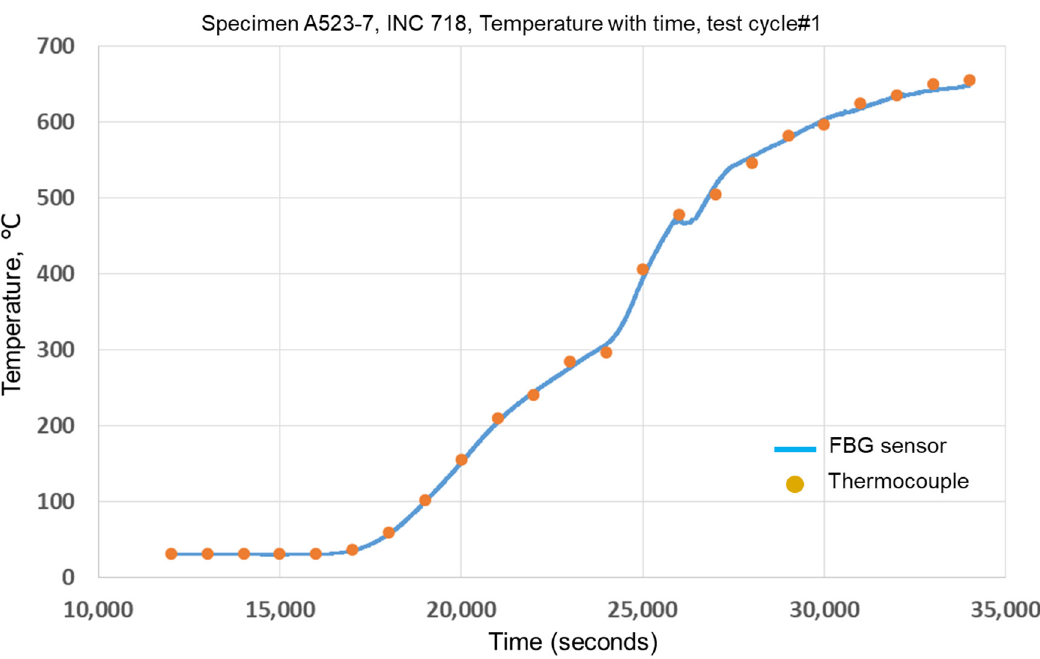
Figure 16. Temperature data acquired using embedded FBG sensor and thermocouple on INC 718 specimen A523-7 (test cycle#1).